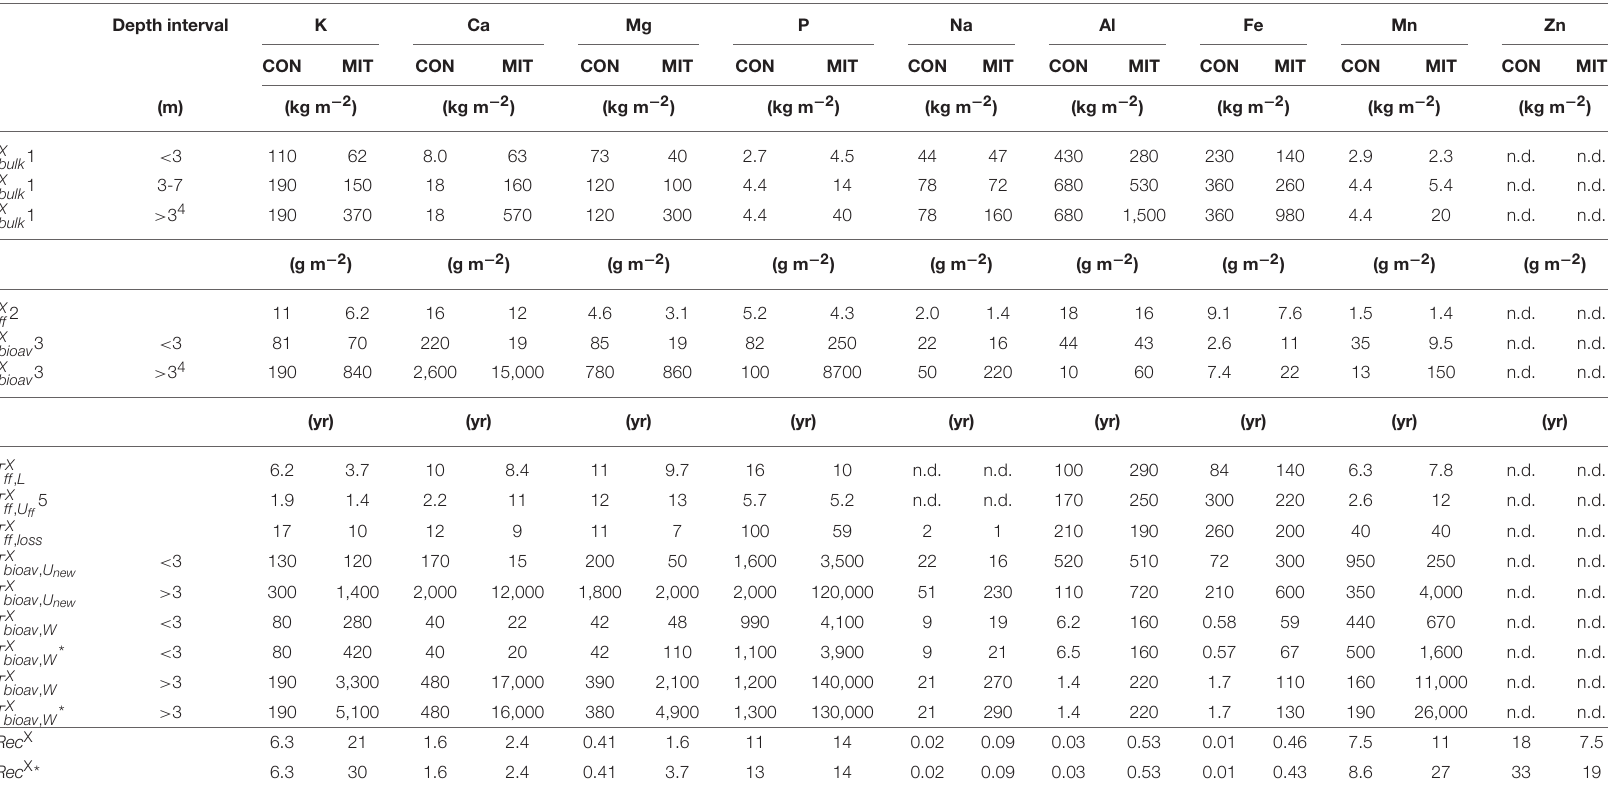
TABLE 5 | Inventories ( I X j ), turnover times ( T X j ), and recycling factors ( Rec X ) at CON and MIT. Depth interval